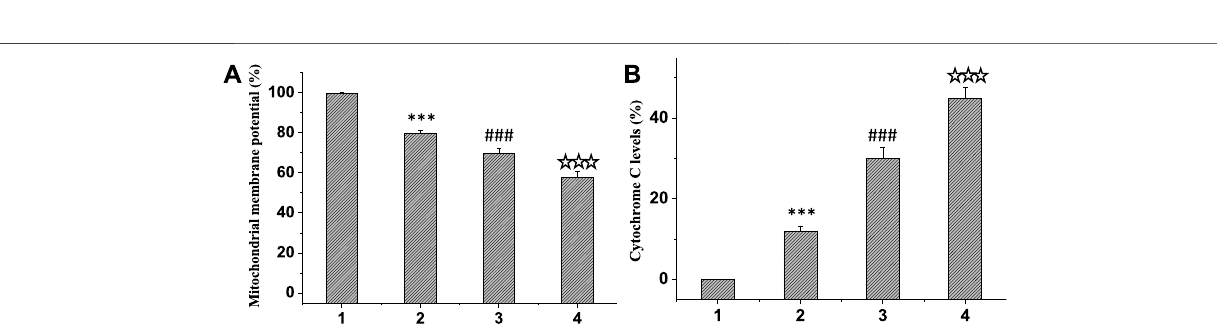
incubation time, the yellow gradually becomes darker. In comparison with the two groups, the distribution of TPP-CZL was signi fi cantly higher than that in CZL, indicating that TPP can promote the aggregation of micelles to mitochondria of liver